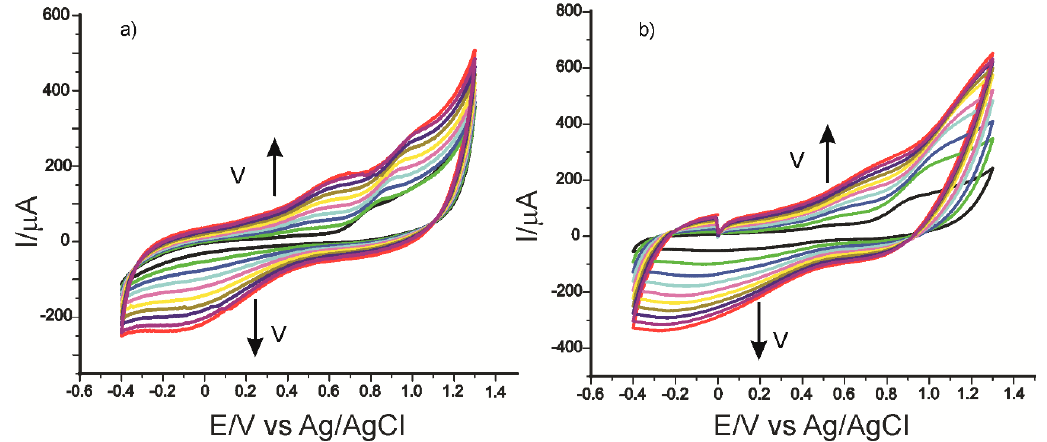
potential increase 7 mV at a frequency of 15 Hz.